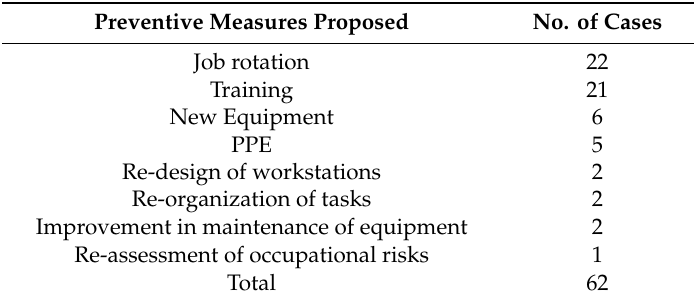
Table 10. Preventive measures proposed as consequence of the investigation.